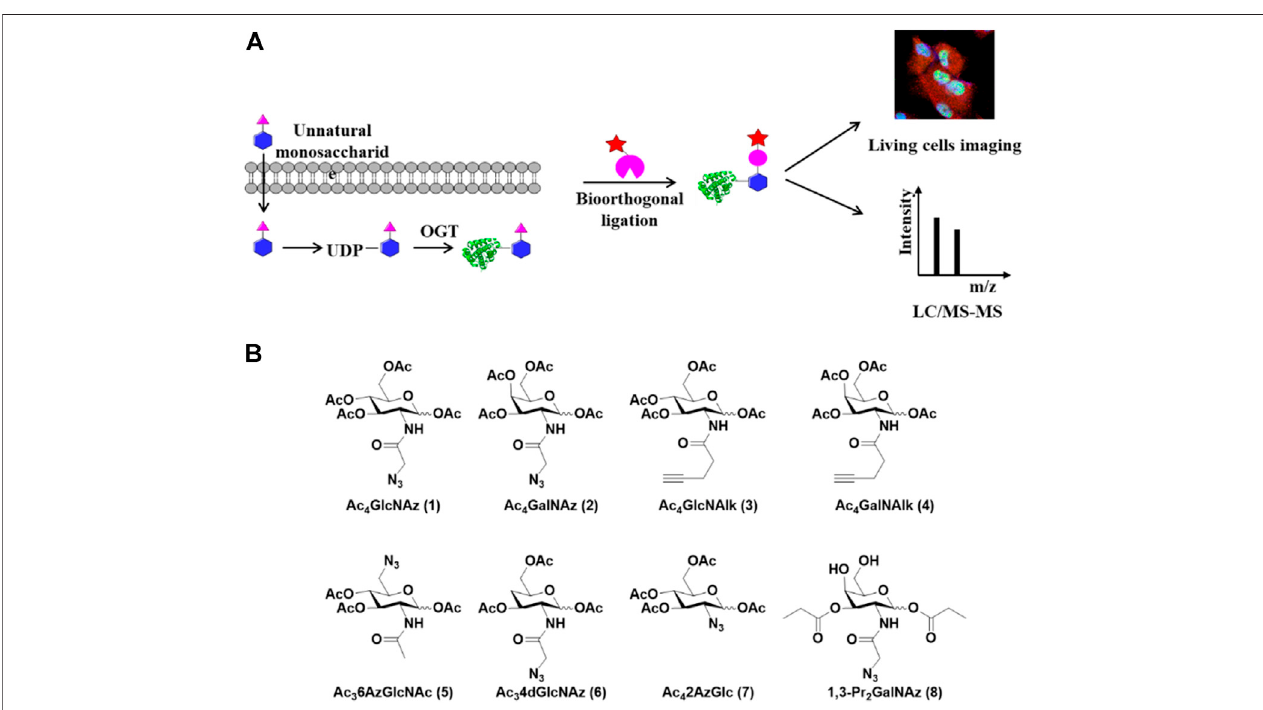
FIGURE 2 | Metabolic labeling strategy for capture and detection of O-GlcNAcylated proteins. (A) Schematic of metabolic labeling. Unnatural monosaccharides enter cells and are metabolically converted to UDP-GlcNAc analogs which serve as donors for O-GlcNAcylation by OGT. The labeled O-GlcNAcylated proteins are enriched throughbioorthogonalreactionsandanalyzedbyLC-MS/MSorimagedinlivingcells. (B) MetabolicchemicalreportersusedforthelabelingofO-GlcNAcylated proteins in cells.